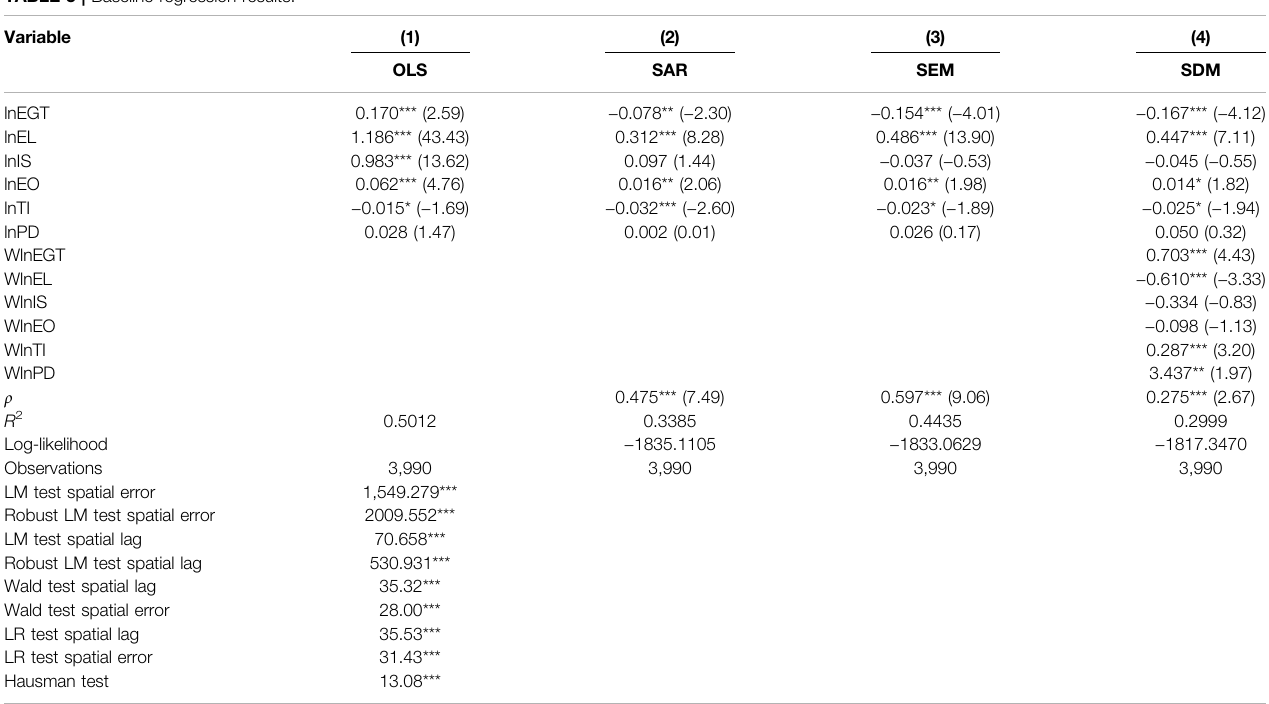
TABLE 3 | Baseline regression